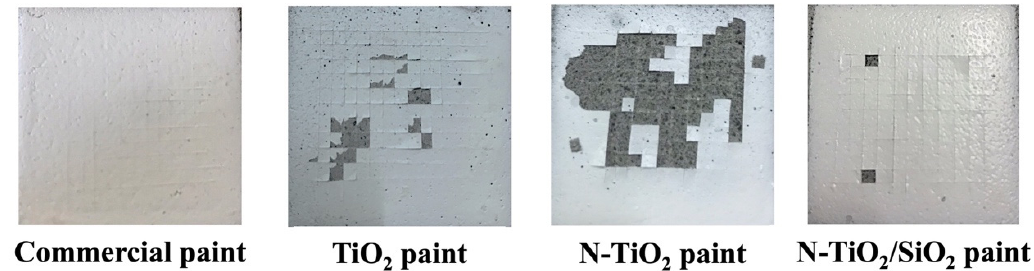
Figure 8. The adhesion tests of commercial paint (without photocatalyst), TiO 2 paint, N-TiO 2 paint, and N-TiO 2 @SiO 2 paint .